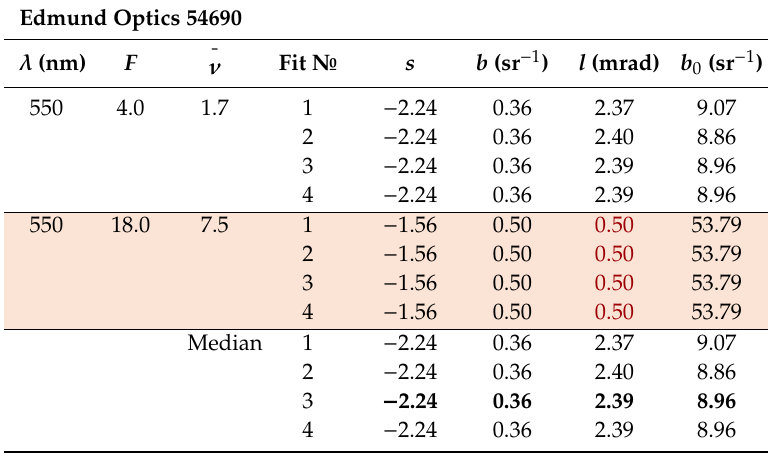
Table A1. Fit results for the lens Edmund Optics 54690.